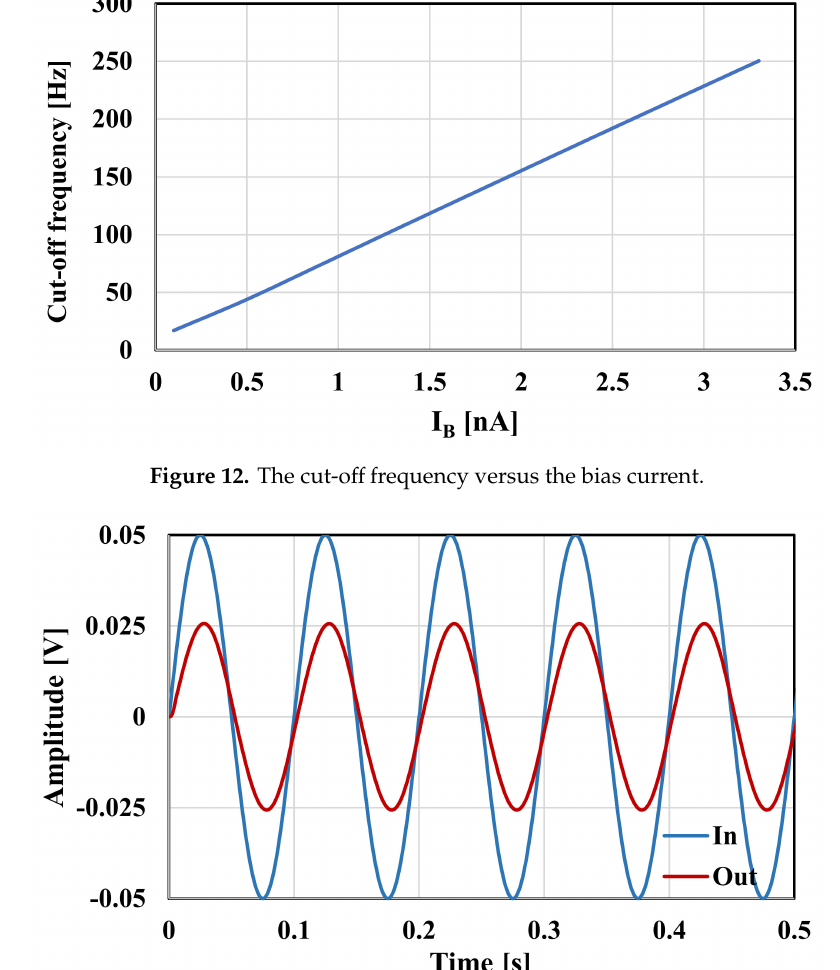
Figure 13. The transient response of the filter for input sine wave with V inpp = 100 mV and 10 Hz.